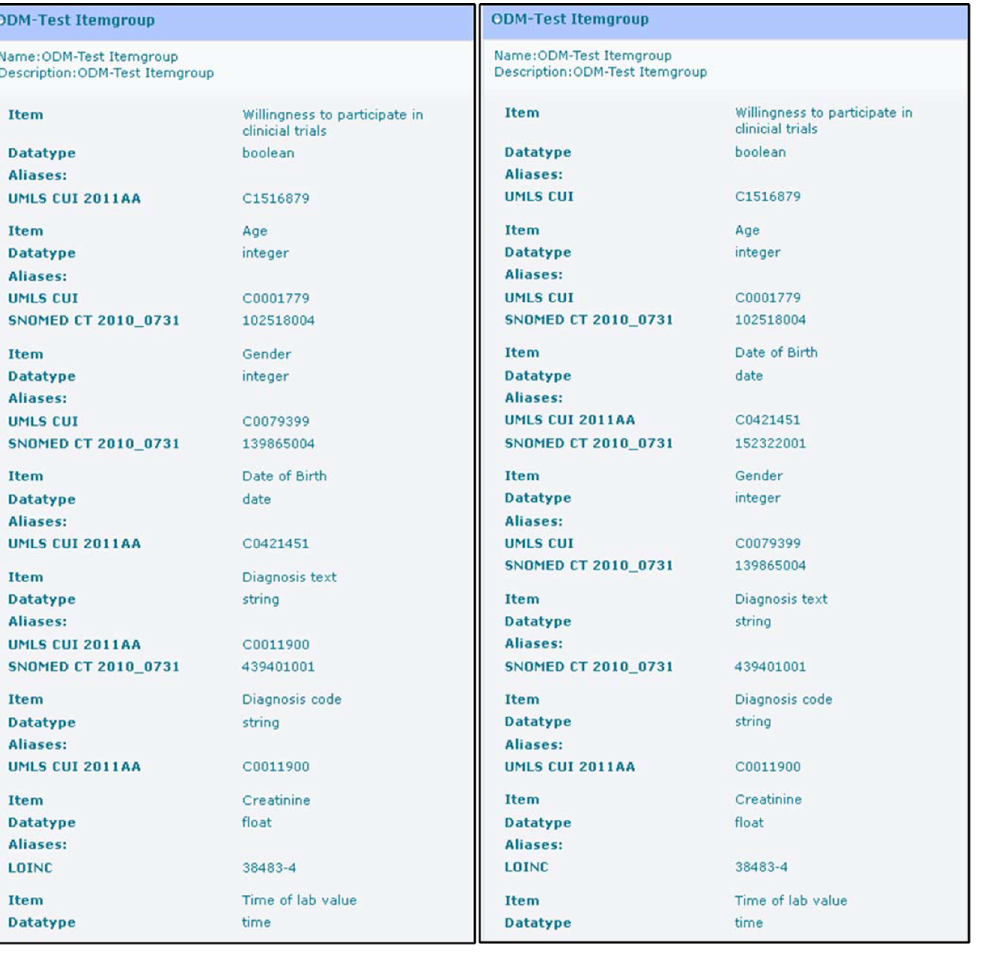
Figure 2. Detailed view of the forms from Fig. 1 with UMLS Concept Unique Ids (CUI). For instance, it can be seen that the first item of both forms has assigned the same CUI (C1516879). In addition, information about the value domain for each item is provided (for example: data type boolean).